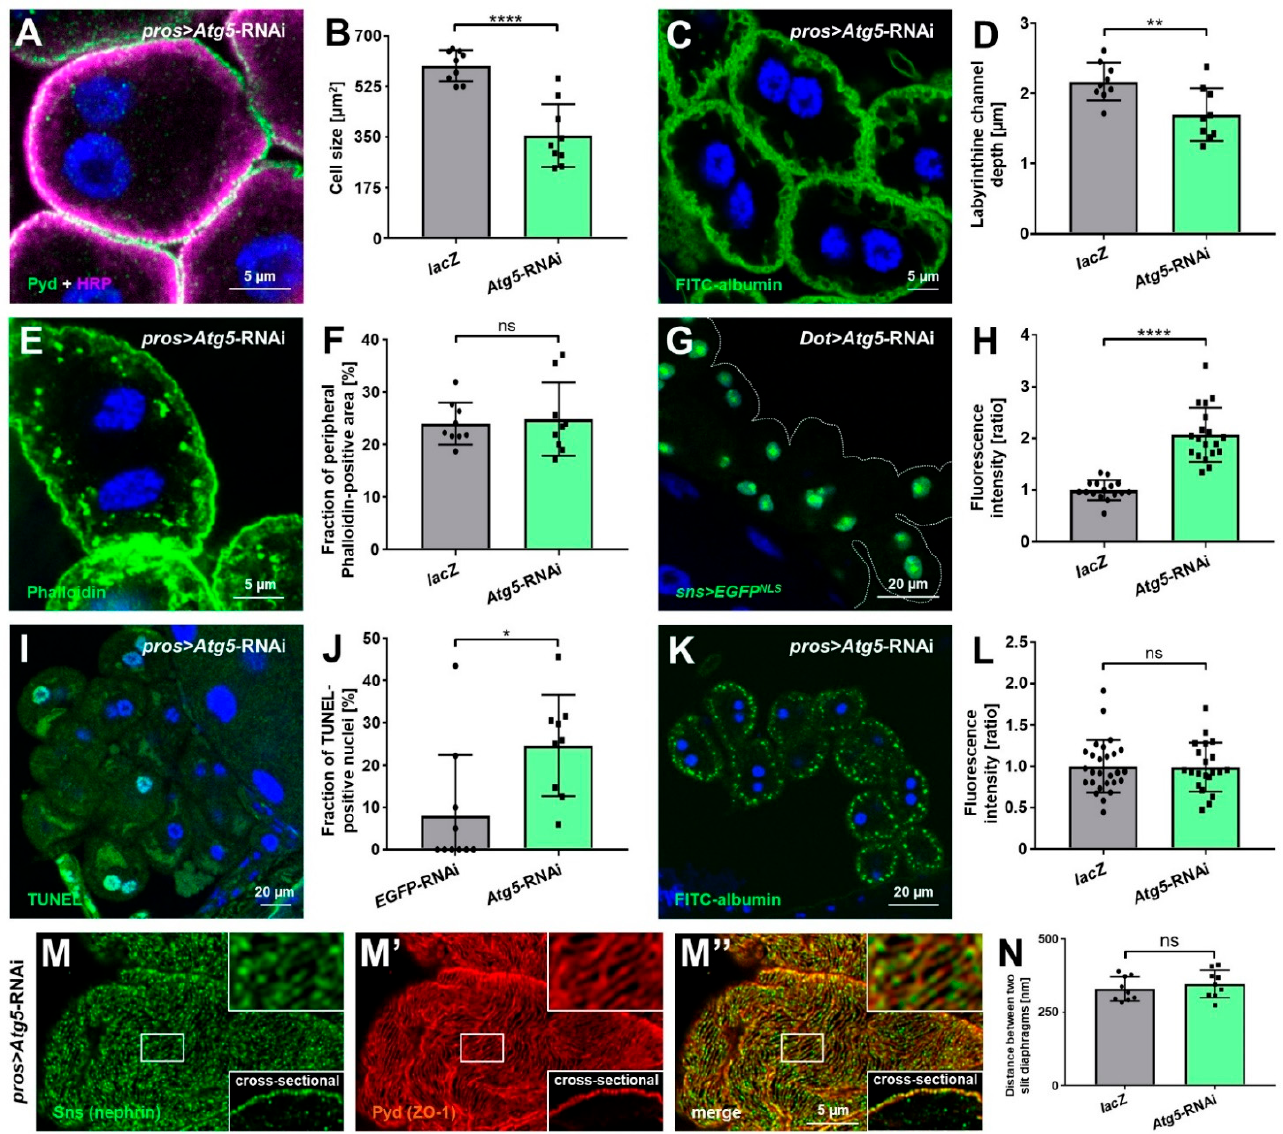
Figure 5. Basal autophagy in nephrocytes limits expression of sns (nephrin) and promotes survival but is dispensable for slit diaphragm formation and endocytic function. ( A ) Nephrocytes were stained for Pyd to assess cell size. Co-staining with HRP confirms the correct localization of Pyd at the cell membrane. Cell size is smaller in cells expressing Atg5 -RNAi under the control of pros-GAL4 compared to the lacZ expressing control cells (Figure 2E). ( B ) Quantification of cell size by measurement of the area outlined by Pyd staining in the cross-sectional plane in conditions analogous to (A and Figure 2E). Data shows mean ± standard deviation, n = 9 animals per genotype with three cells for each animal (every dot and square represents one animal here and throughout the figure). Sta- tistical difference was assessed by unpaired t-test, p < 0.0001 (****) for Atg5 -RNAi. ( C ) Nephrocyte labyrinthine channels are visualized by passive FITC-albumin tracer diffusion into the channels af- ter brief fixation. Channels are shortened in cells expressing Atg5 -RNAi compared to the lacZ ex- pressing control cells (Figure 3E). ( D ) Quantification of labyrinthine channel depth analogous to conditions in (C and Figure 3E) based on three representative measurements in sections of the cell surface that are not in immediate proximity to a neighboring cell. Data shows mean ± standard deviation, n = 9 animals per genotype with three cells for each animal. Statistical difference was assessed by unpaired t-test, p < 0.01 (**) for Atg5 -RNAi. ( E ) Actin marker phalloidin shows a regular peripheral actin network in lacZ expressing control cells (Figure 3A) with linear cortical actin and the adjoining subcortical actin network. Expression of Atg5 -RNAi does not alter the peripheral actin network. ( F ) The quantification of the fraction of the cellular area in the cross-sectional plane that is